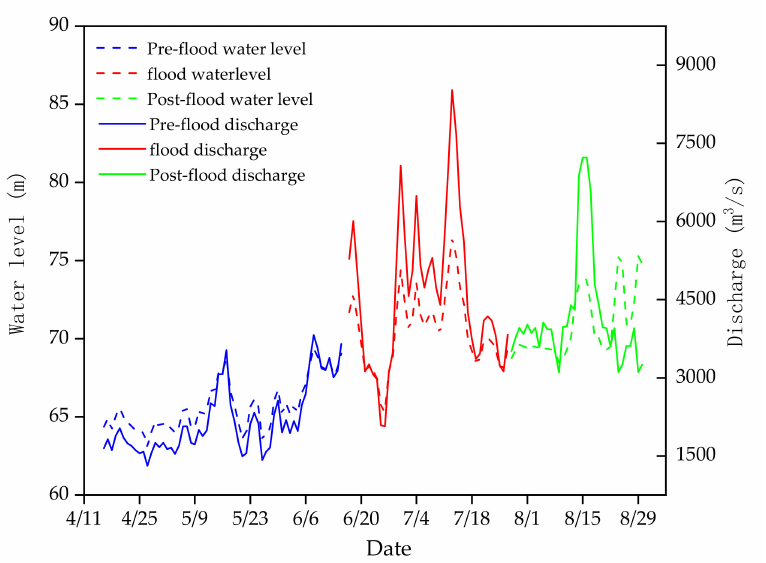
Figure 2. Variation in discharge and water level in the Laibin section of the Pearl River from 16 April to 30 August